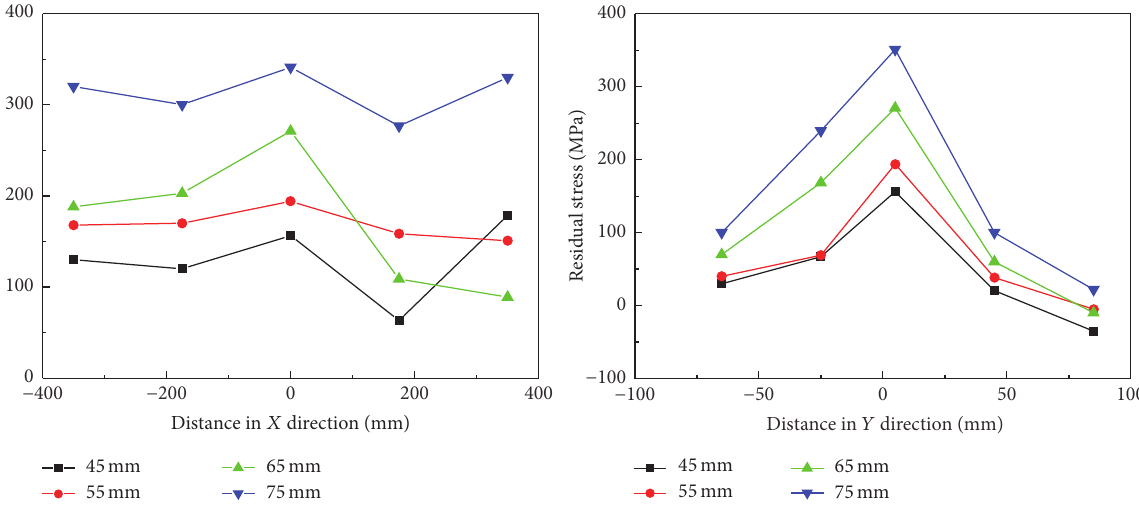
Figure 6: Longitudinal residual stress.